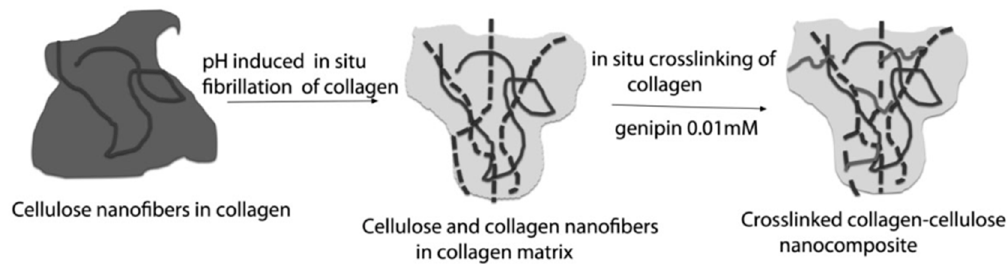
Figure 4. Schematic representation of the preparation of nanocomposites by pH-induced fibrillation with and without crosslinking. The figure above was adapted with permission from the cited reference [83].